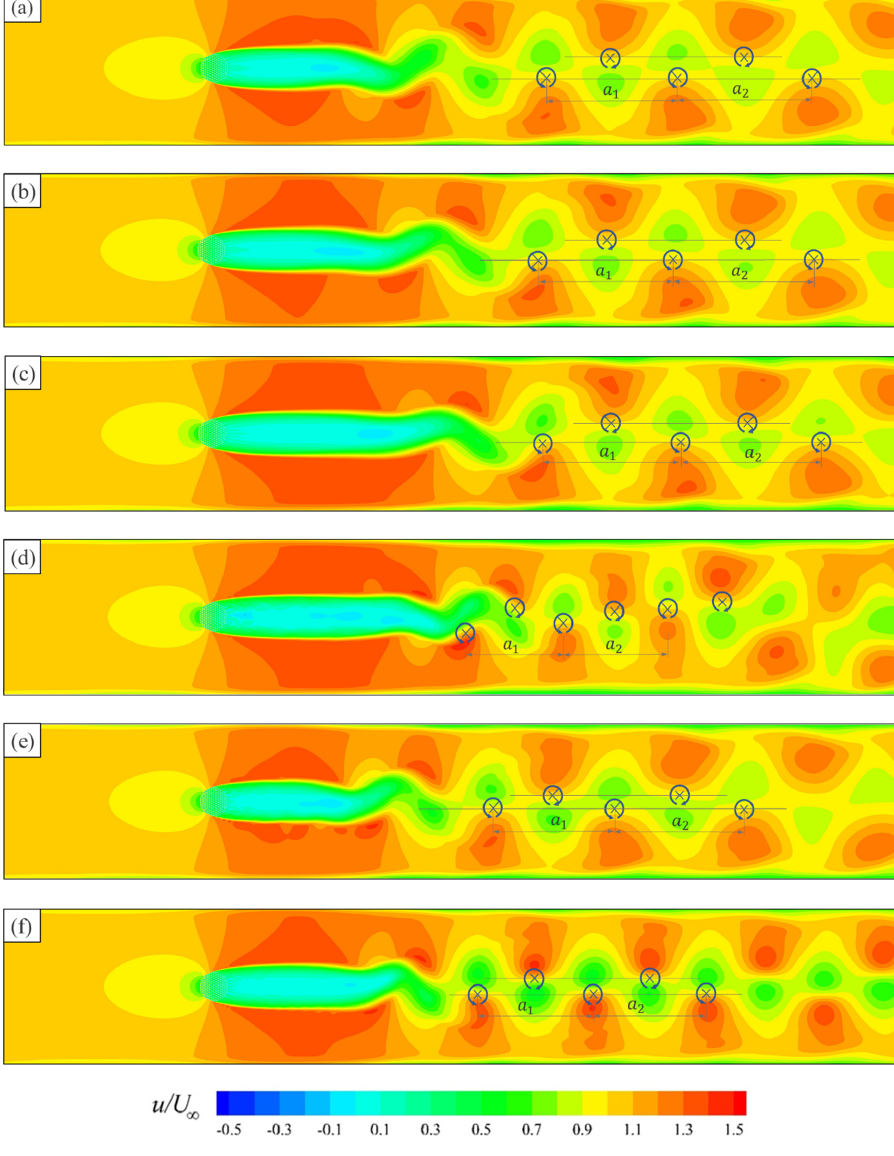
Figure 9. Contours of instantaneous velocity distribution for Φ = 0.1 and D = 22 cm colored by velocity u . ( a ) case I, ( b ) case II, ( c ) case III, ( d ) case IV, ( e ) case V, and ( f ) case VI. Arrows indicate the direction of the vortex rotation.